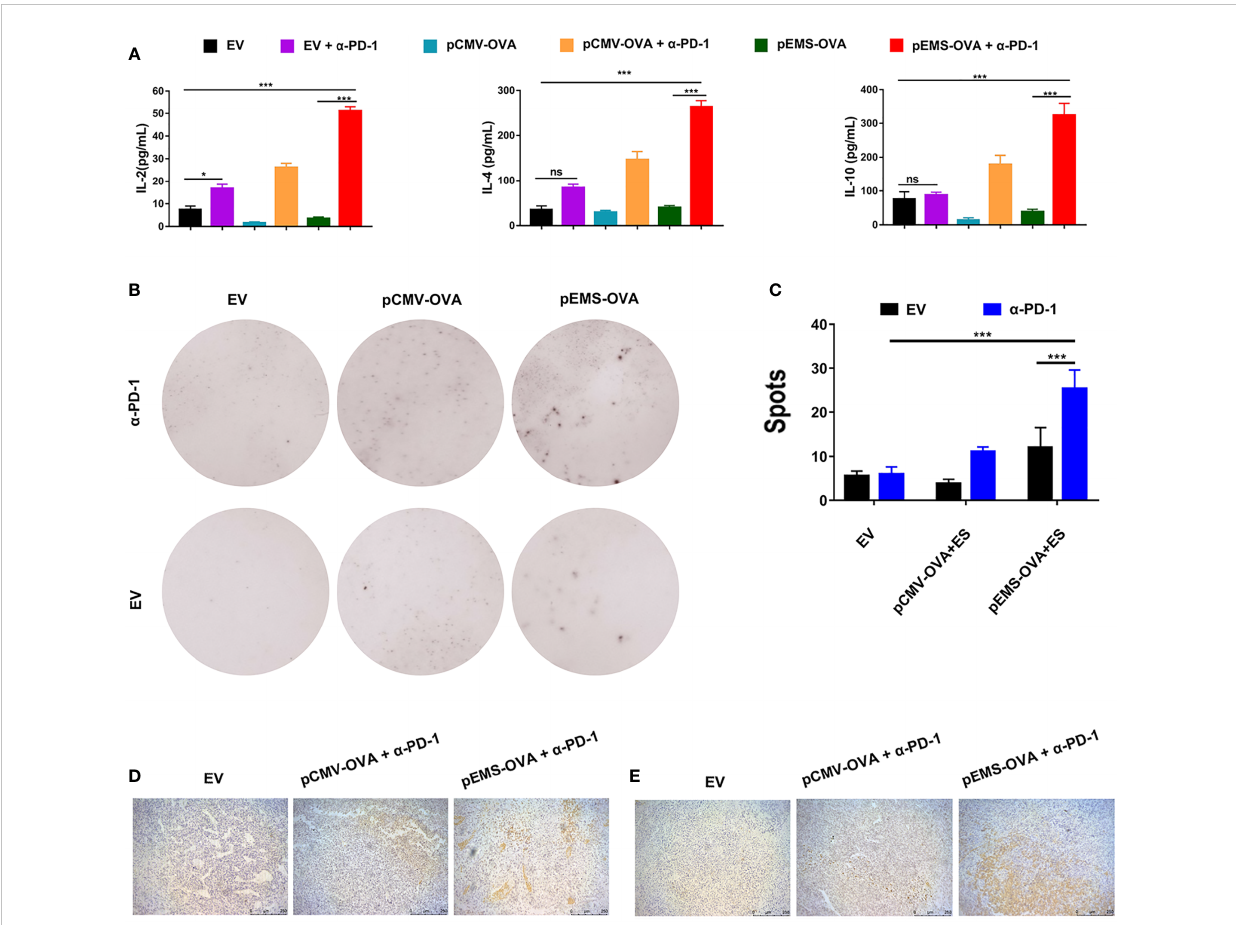
FIGURE 3 Immune response effect of DNA vaccination and intramuscular gene transfer of PD-1 antibody combination for MC38-OVA-bearing mice. (A) Levels of IL-2 (left), IL-4 (middle), and IL-10 (right) in fl ammatory mediators in the serum of mice receiving six different treatments were detected by ELISA on day 29. (B) Representative IFN- g ELISPOT wells for splenocytes isolated from various six treatment groups. (C) Quanti fi cation of IFN- g positive spots in the six treatment groups. Immunohistochemical analysis of CD4 + (D) and CD8 + (E) T-cell in fi ltration in MC38 tumors from mice treated with three kinds of vaccine combined pVAX- a -PD-1-Fc groups. Scale bars: 250 m m. Results are representative of three independent experiments and are expressed as the mean ± SD; n = 5 per group. One-way ANOVA was used to calculate the p -value, *p < 0.05, ***p < 0.001. ANOVA, analysis of variance; ELISPOT, enzyme-linked